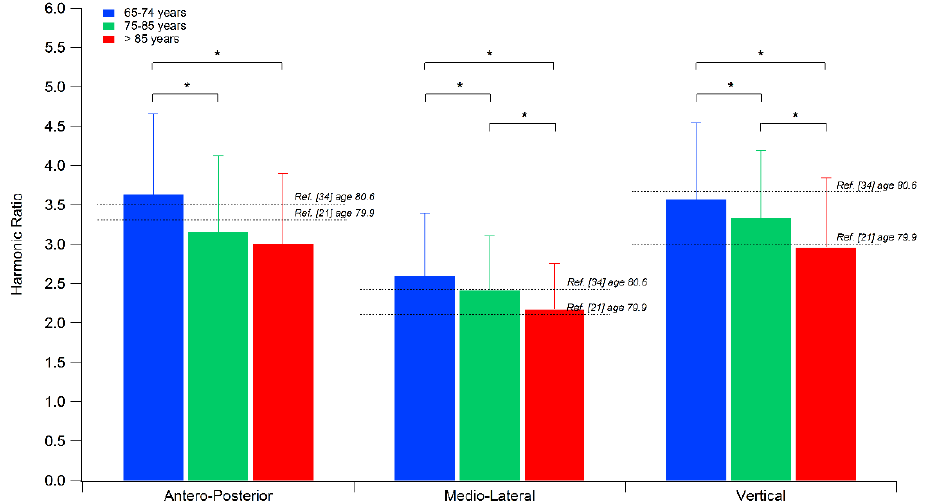
Figure 3. Harmonic Ratio values in AP, ML, and V directions for the three groups of tested older adults. Data from the present study are compared with those previously reported for similar age ranges (Refs. [21] and [34]).